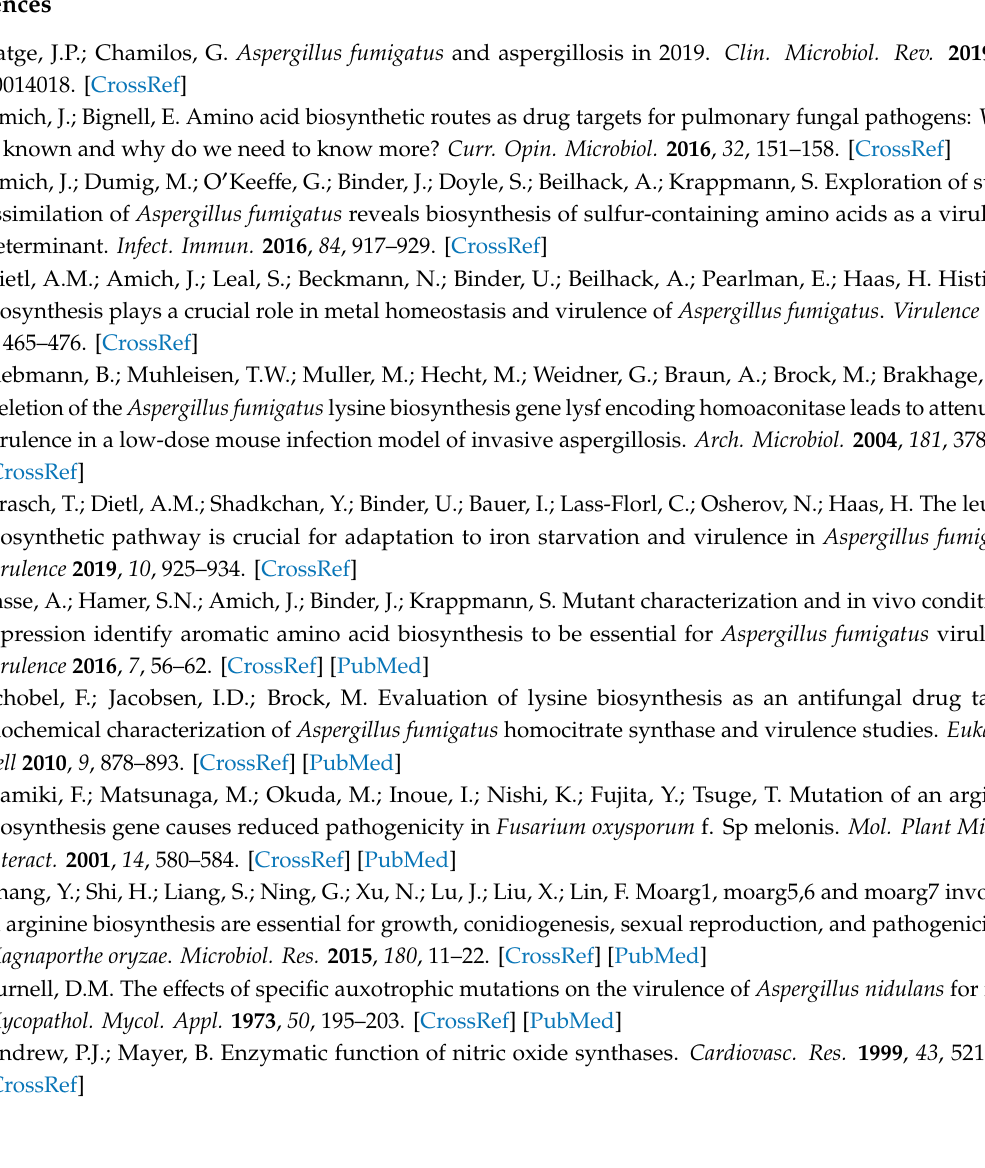
Figure S1: Deletion and reconstitution of argJ and argB , Table S1: Arginine biosynthetic genes in A. fumigatus and human homologs identified by BLASTP (blast.ncbi.nlm.nih.gov / Blast.cgi) searches, Table S2: Primers used for generation of ∆ argJ , ∆ argB , argJ C and argB C , Table S3: Fungal strains used in this